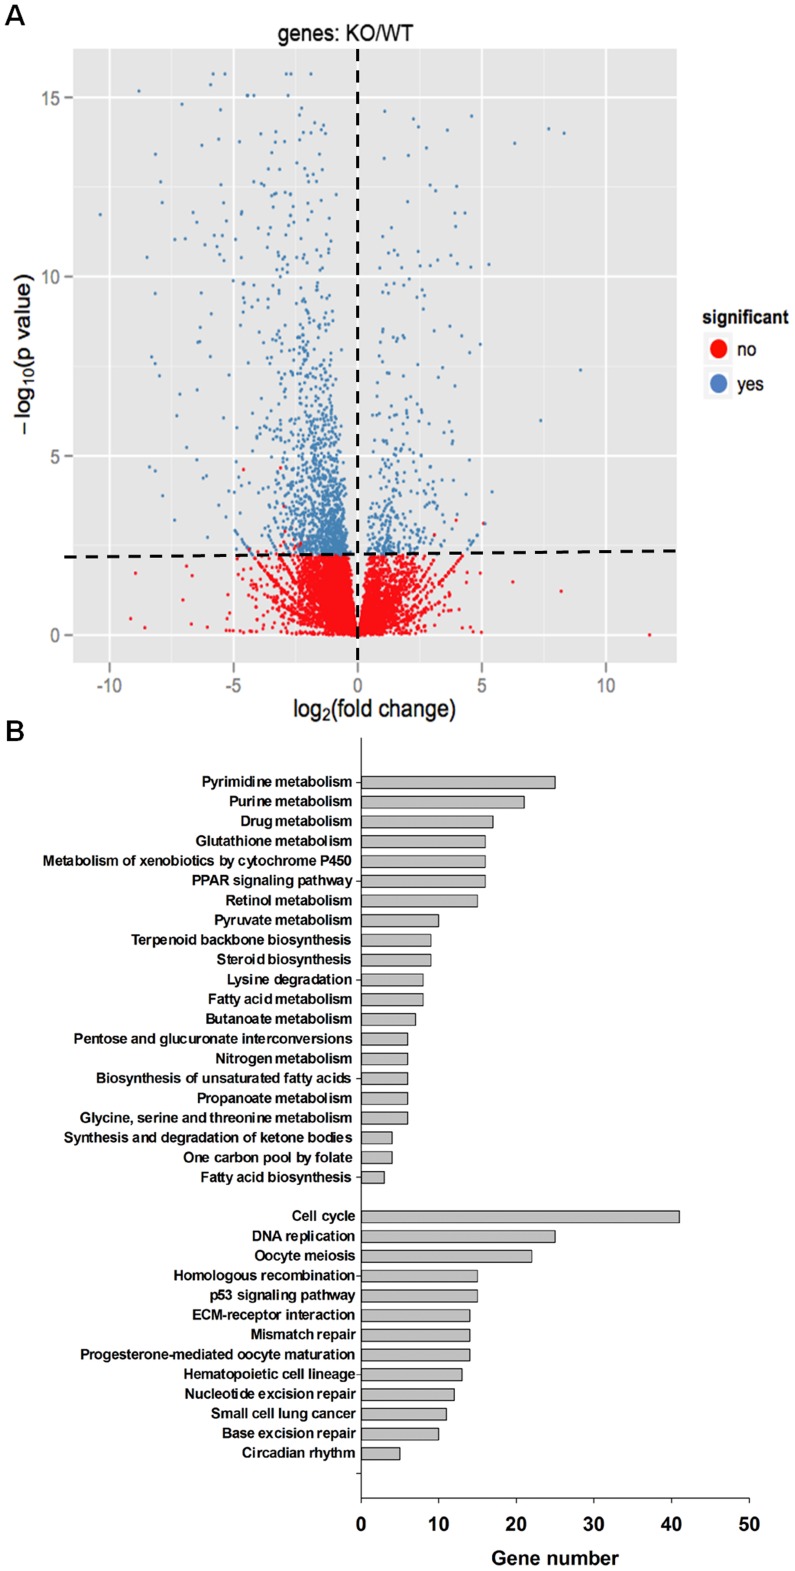
Visualization of RNA-sequencing for differential expressed genes in regenerating wild type (WT) and PPARβ-null (KO) mouse livers.(A) Volcano plots showing the magnitude of gene expression ratios (log2) (x-axis) as a function of difference between WT and KO, are displayed on the y-axis [-log10 (p value)]. Horizontal dotted line corresponds to a p value cutoff of 0.01. Vertical dotted line delimits up- and down-regulation of KO/WT. (B) Pathway analysis of the 1344 differentially expressed genes with significance by DAVID. The 1344 transcriptomes significantly differentially expressed were extracted with a Benjamini-Hochberg corrected p value <0.005 for pathway analysis. 437 out of 1344 genes could be assigned to 34 KEGG pathways that include 21 metabolism and 12 cell proliferation pathways. The number of genes involved in each pathway is indicated.